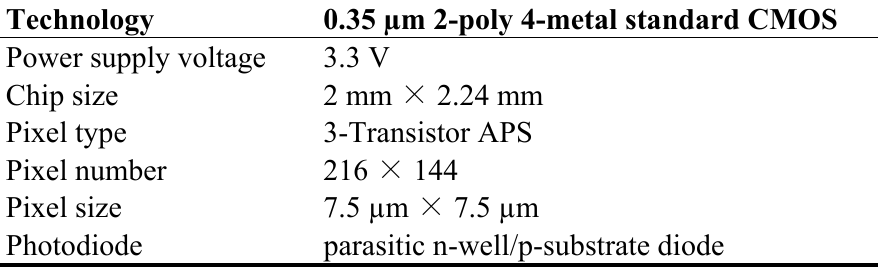
Table 1. Specifications of the implantable CMOS imaging chip.